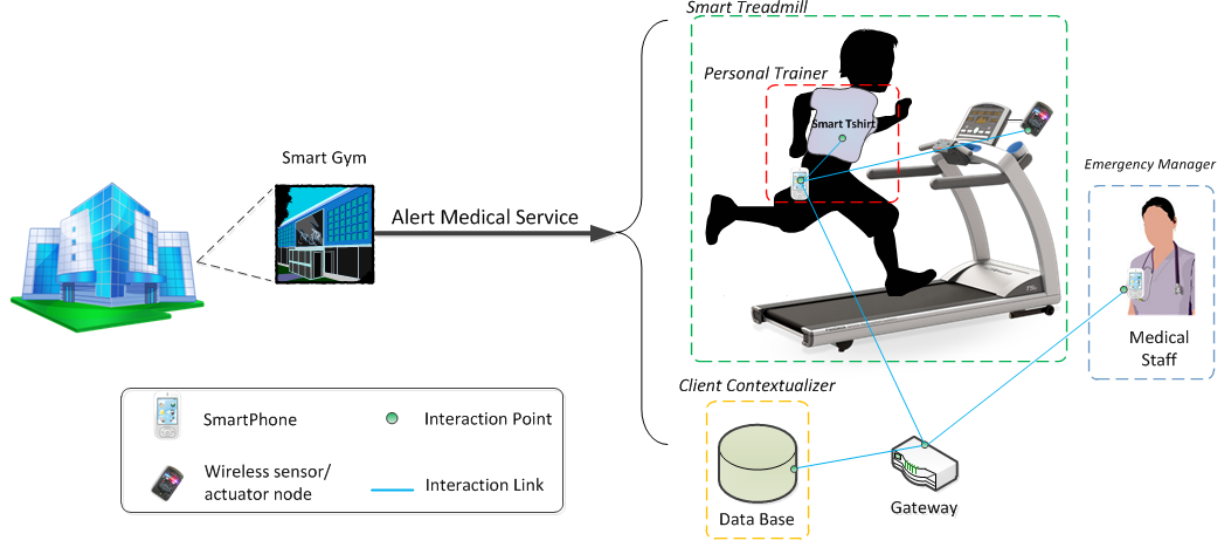
Figure 10. Diagram of the medical service provided by the smart gym. The smart gym is part of a smart